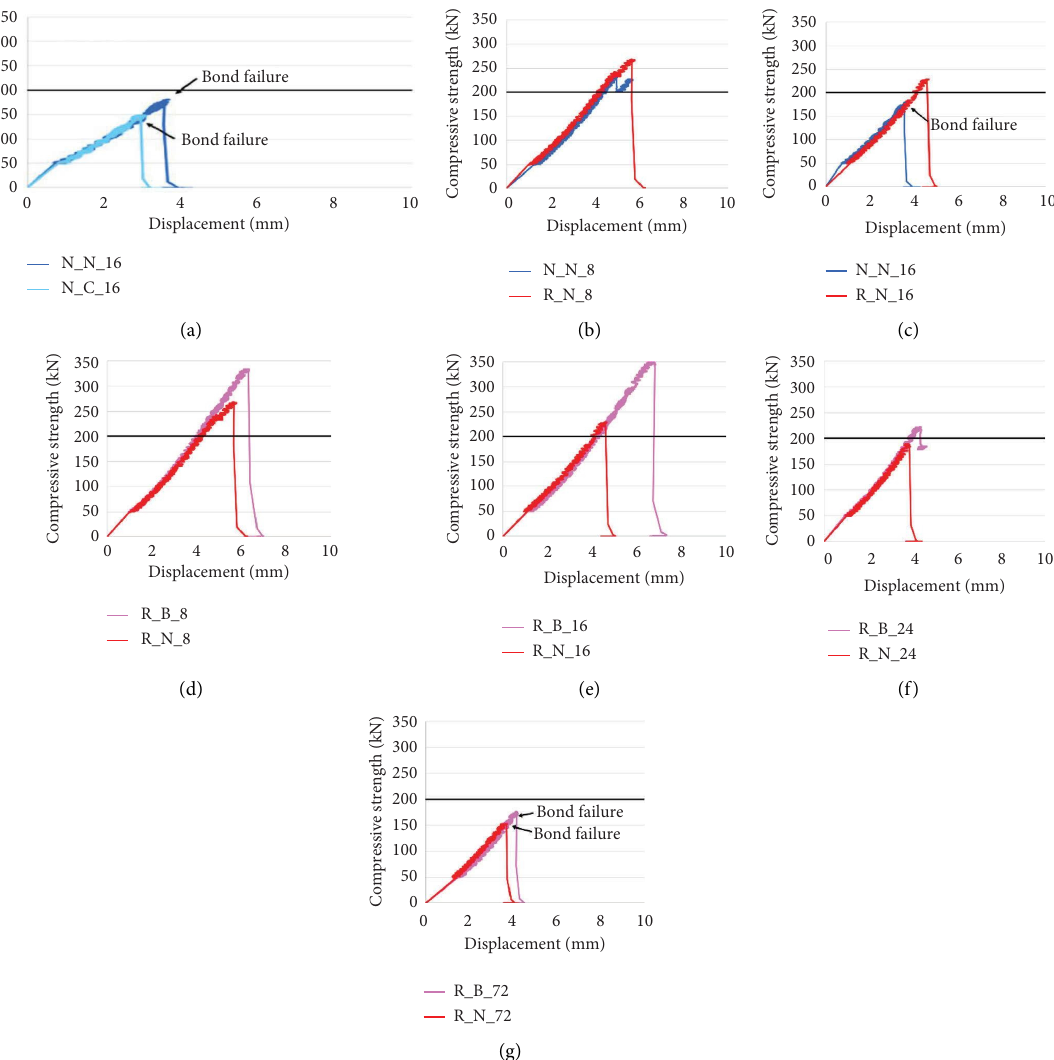
Figure 7: Maximum stroke and load on the 28 th